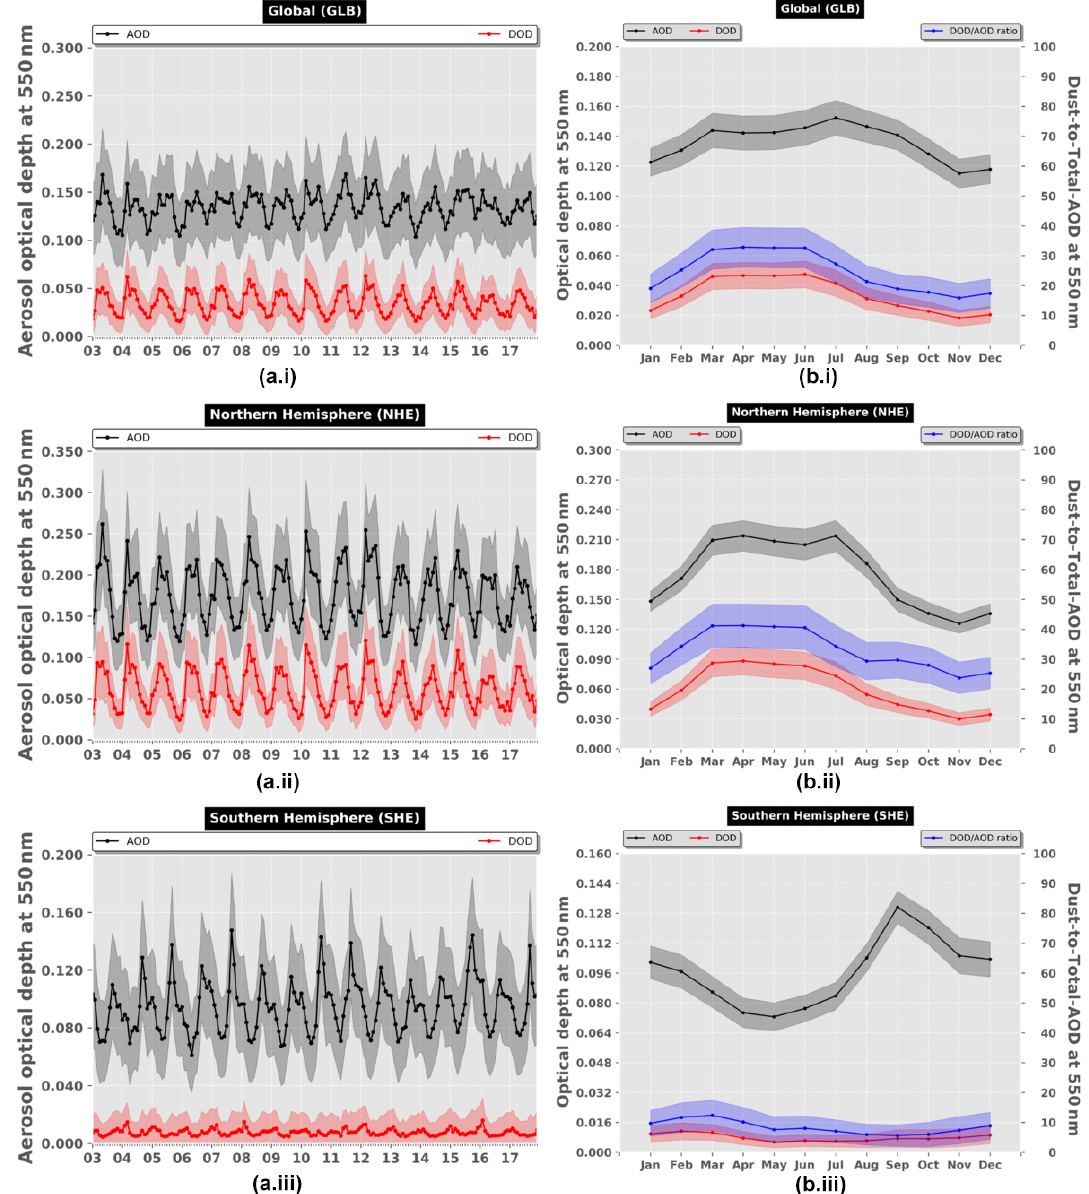
Figure 10. Interannual (a) and intra-annual (b) variability, representative for the period 2007–2016, of monthly MODIS AOD 550nm (black curve) and DOD 550nm (red curve) regionally averaged for (i) the whole globe (GLB), (ii) the Northern Hemisphere (NHE) and (iii) the Southern Hemisphere (SHE). The blue curves in the intra-annual plots depict the dust-to-total AOD 550nm ratio (expressed in percentage; right y axis). The shaded areas correspond to the total